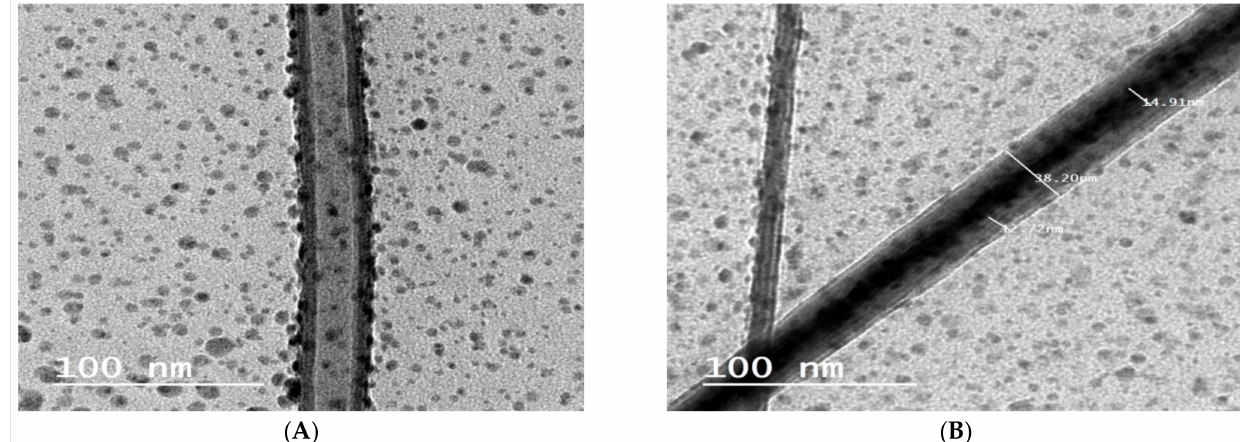
Figure 5. High resolution transmission electron micrographs (HRTEM) of the optimized formula (E2) showing; ( A ) core- sheath structure where a clear visual of the incorporated nanoemulsion is observed. Additionally, demonstrating the adsorption of some of the NE on the fiber surface. ( B ) NFs with clearly discriminated core and sheath with defined